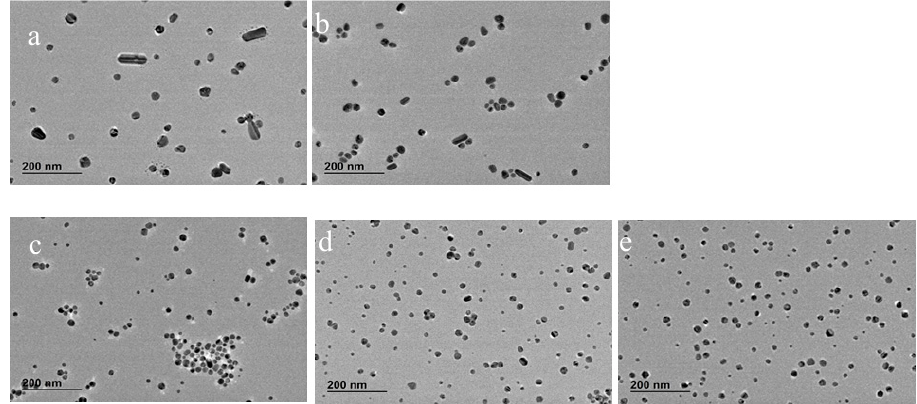
Figure 6. TEM images of AgNPs synthesised using TA solution thermally preconditioned for ( a ) 0 min, ( b ) 15 min, ( c ) 45 min, ( d ) 90 min and ( e ) 180 min.